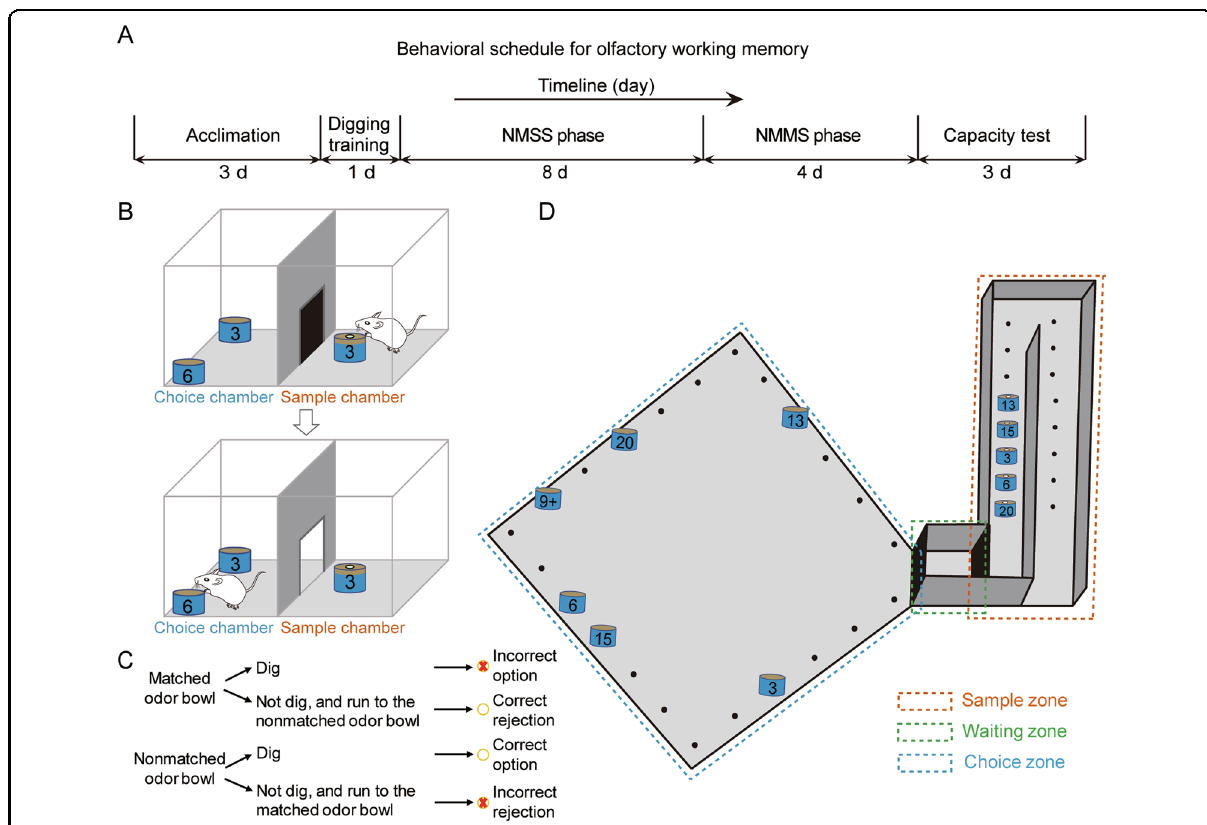
Fig. 1 Schematic illustration of the olfactory working memory capacity task. A Timeline of the novel task. B The non-matching-to-single-sample (NMSS) learning phase of the task. During the NMSS phase, each mouse was presented with two stimuli (sample odour stimulus and novel odour stimulus) per trial and trained to dig for pellets in the scented bowls with novel odours. In each trial, mice were initially placed in the sample chamber and allowed to explore and detect the sample odour. Then, the mice were allowed to enter the choice chamber and choose between the sample odour bowl and the novel odour bowl. C Different types of responses in the NMSS phase. D The non-matching-to-multiple-sample (NMMS) learning phase and capacity-testing phase of the task. During the NMMS phase, the mice were placed in the sample zone to detect the sample stimulus, allowed to enter the waiting zone for 5 s, and then allowed to go through the door to choose between the sample odour bowl and novel odour bowl on the platform. Once the mice performed reliably in the NMMS rule-learning phases, they underwent a WM capacity test. The procedure was similar to that of the NMMS rule-learning phase, except that the number of sample odours that the mice were required to remember was gradually increased until two consecutive incorrect responses were